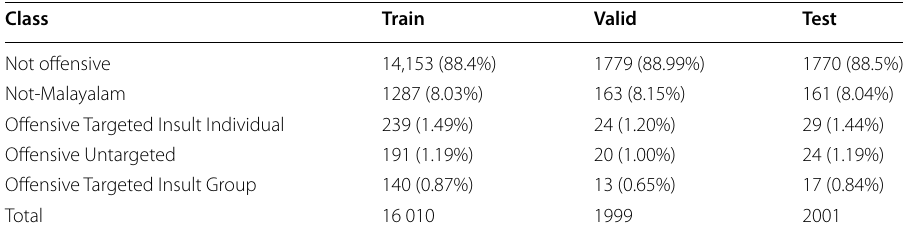
Table 3 Offensive language detection—OLD data statistics [44] Class